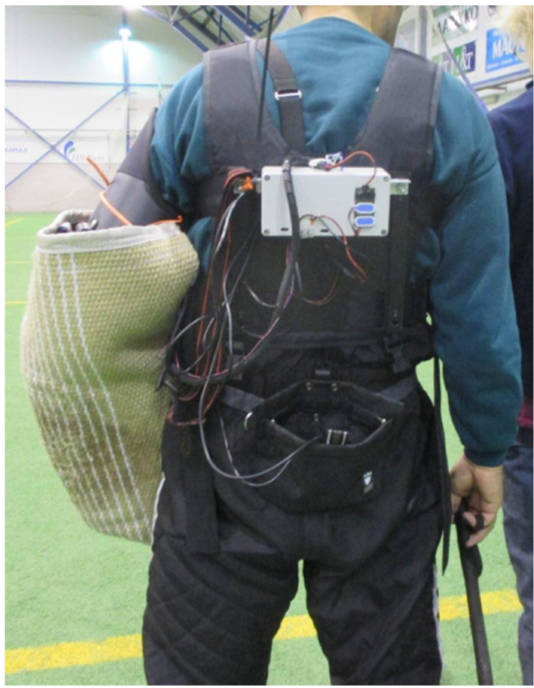
Figure 2. Measurement equipment on the